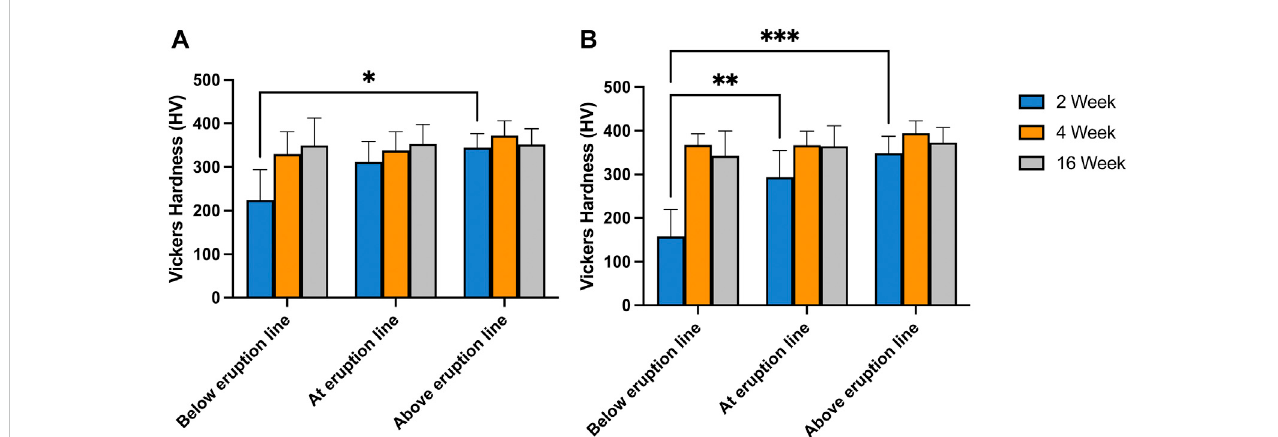
FIGURE 8 Vickers Hardness measured at various position along the length of fi rst incisors taken from 2-, 4- and 16-week-old pigs. Panel (A) . presents the average hardnessofenamelmeasured overacross-sectiontaken2 mmbelow, atand2 mmabovegum line.Inpanel (B) onlytheresults fromtestsperformed30 µm fromthesurfaceofthetootharepresented.Theresultsindicatenosigni fi cantdifferencebetweenthehardnessofthevariouslocationsprobesfortheincisors of 4- and 16-week-old pigs. In incisors from 2-week-old pigs, the hardness of enamel below gum line is signi fi cantly lower than the hardness above eruptionline( p =.02) (A) .Thesurfacemicrohardnessofthesamepigsbeloweruptionlinearesigni fi cantlylowerthanthevaluesateruptionline( p =.005)and above eruption line ( p < .001) (B)